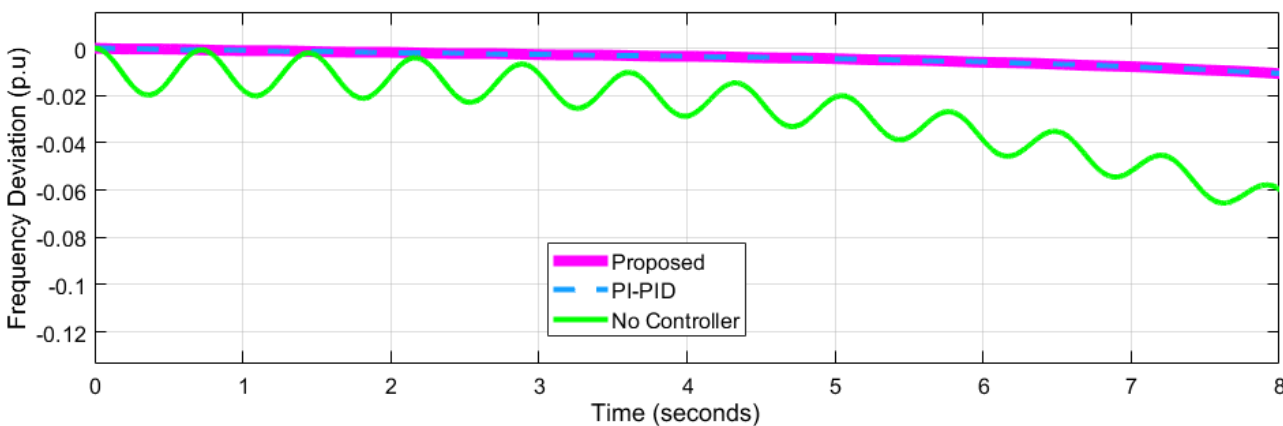
Figure 10. Case 3: frequency deviation at (K p = −1.8196,K i = −0.0009) for network 2.